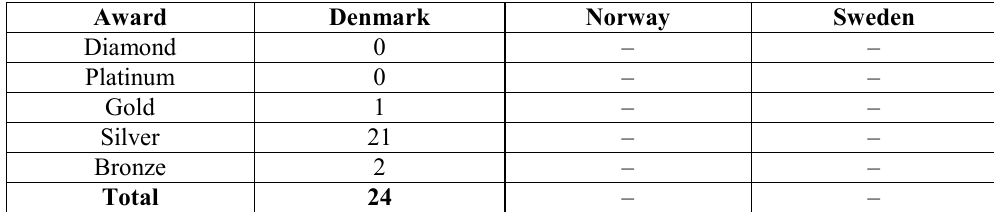
Table 3. DGNB Projects (Developed by